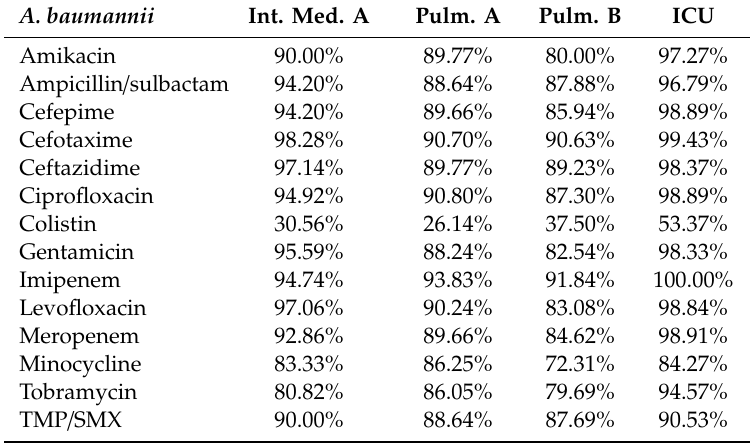
Table A5. Resistance rates for A. baumannii per ward per antibiotic during the 2 years